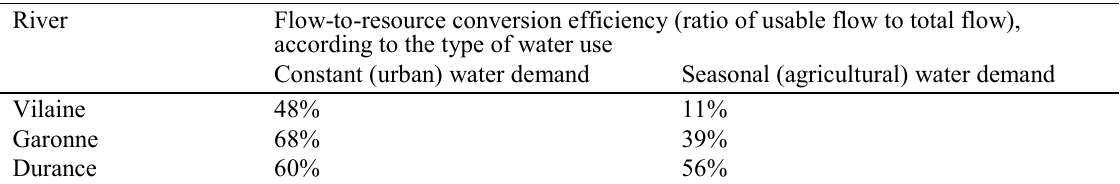
Table 4 Flow-to-resource conversion efficiency simulated for the three French rivers under two hypotheses of water demand. Other hypotheses: no reservoir storage, in-stream reserved flow equal to 10% of the module.